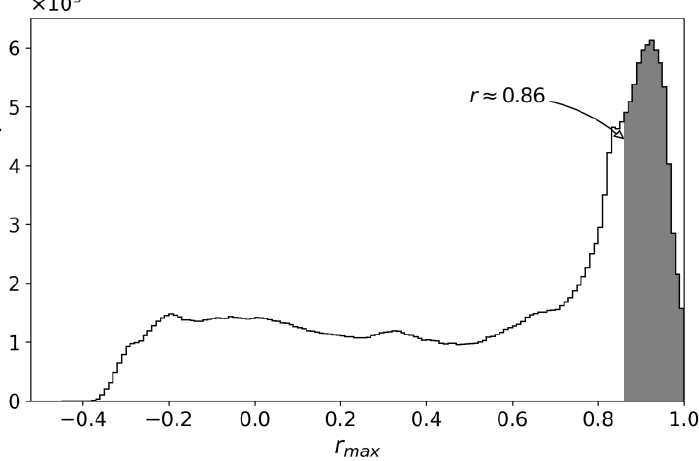
Figure 2. Distribution of maxima r max of cross-correlation functions calculated for the series of deviations of mean daily TEC values from the mean annual TEC dI for the period from 1998 to 2015; the shaded area indicates the values where r max is higher than the threshold A = 0.86.